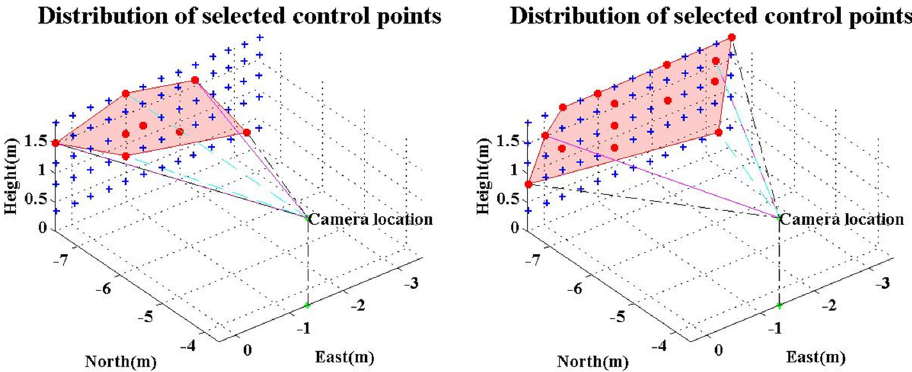
Figure 10. The DOP values of quantity analysis for two smartphones.